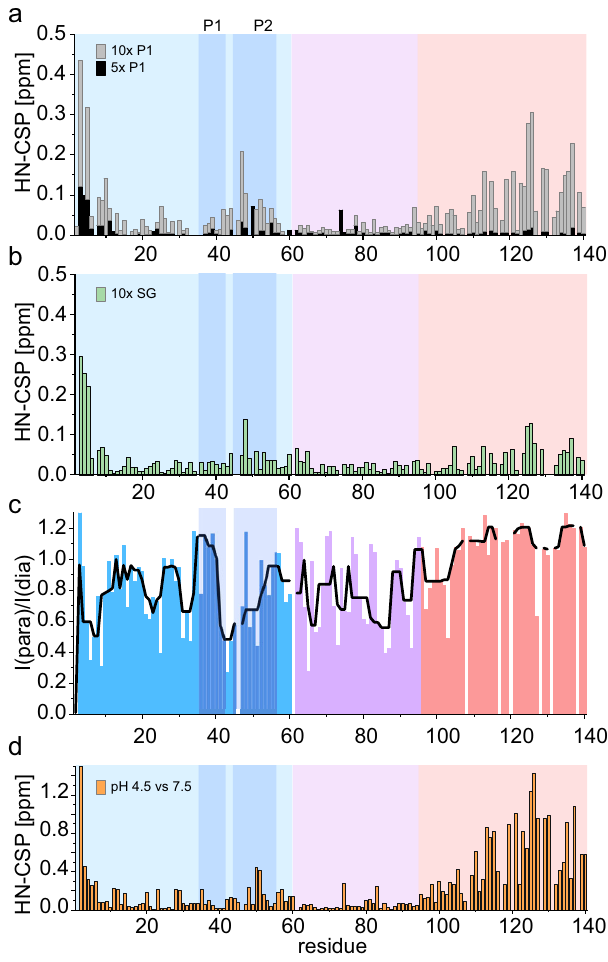
Fig. 4 | The binding of peptide P1 alters the conformational ensemble of WT α Syn. HN-CSPs of WT α Syn upon the addition of a a 5- or 10-fold molar excess of peptide-P1, b a 10-fold molar excess of peptide P1-SG and c NMR PREs of 15 N- α Syn upontheadditionofequimolarMTSL-labelledpeptide-P1.Theblacklinerepresents the median value over a rolling window of fi ve residues. d Difference in chemical shiftsofWT α SynatpH7.5and4.5.Allexperimentswereperformedin20mMTris- HCl buffer, pH7.5,200mM NaCl,15°C. The N-terminalregion isshadedlight blue, NAC is in purple, and the C-terminal region is in red. The P1 and P2 regions are shown in darker blue. Source data are provided as a Source Data fi